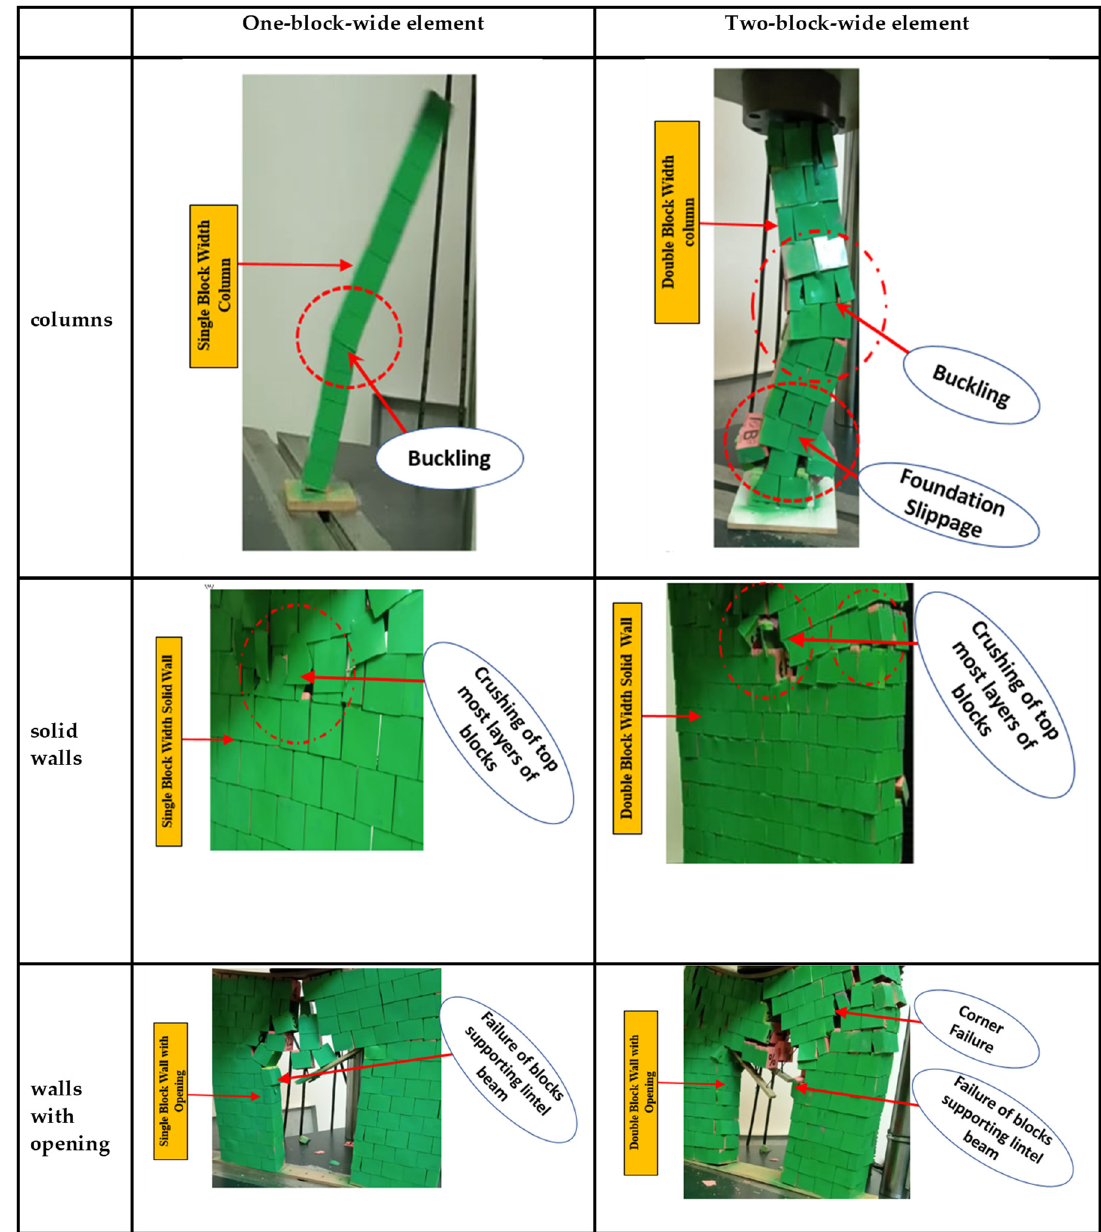
Figure 6. Failure mechanism of tested interlocking plastic blocks-based structural